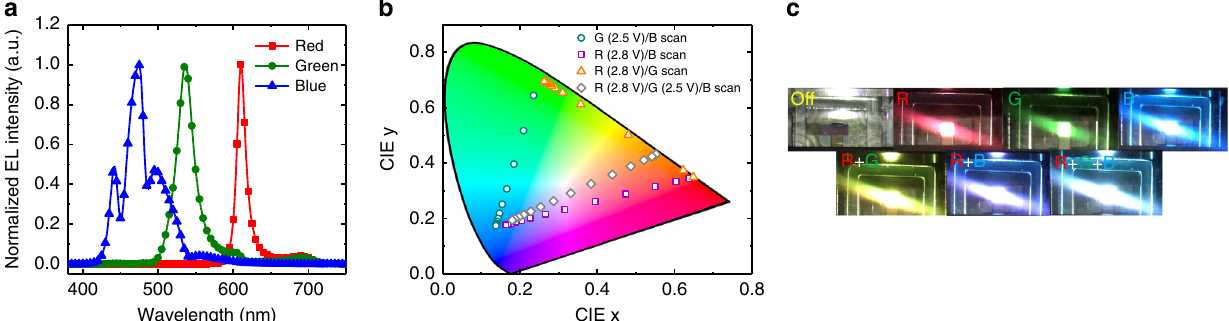
Fig. 4 Color characteristics of vertically stacked full-color organic light-emitting diodes (OLEDs). a Normalized electroluminescence spectra for the independently controlled red ( R ), green ( G ), and blue ( B ) OLEDs. b Commission internationale de l ’ éclairage (CIE) 1931 color coordinates for three, independently controlled R , G , and B OLEDs, under fi xed voltage and with other color unit voltage scanning. c Photographic images of vertically stacked full- color OLEDs with various